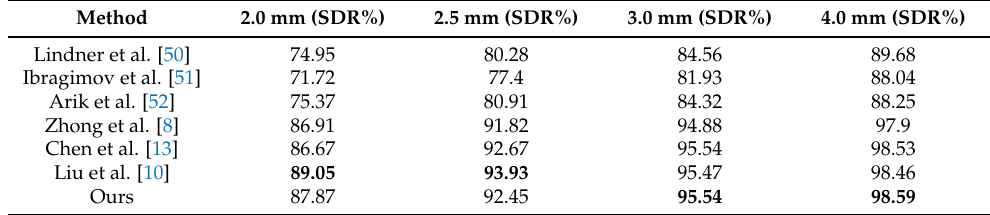
Table 5. Comparisons of SDR of our method with recent compelling methods on ISBI2015 test set (1). Method